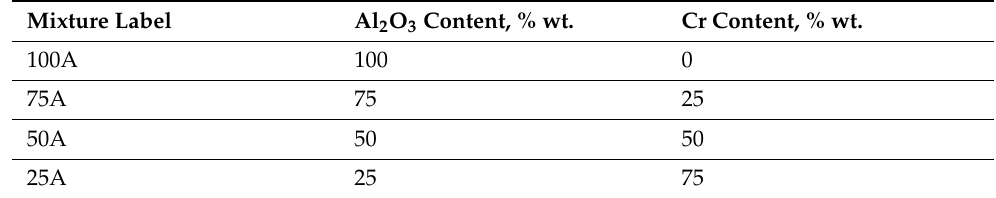
Table 2. Mixture contents used to prepare Al 2 O 3 -Cr composite. Mixture